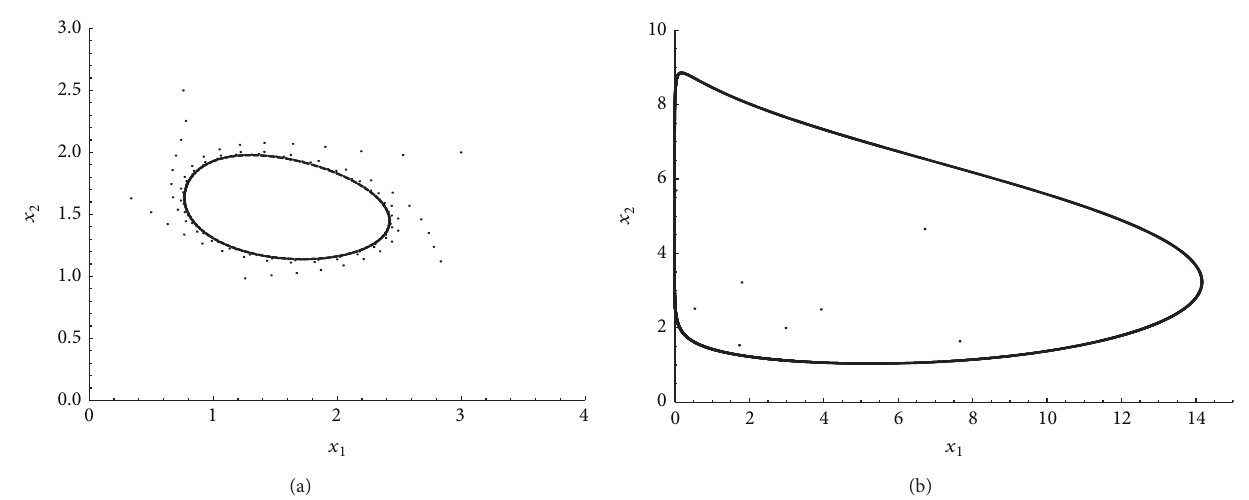
Figure 2: (a) An invariant curve just beyond instability threshold. Parameter values 𝛽 1 = 𝛽 2 = 2 , 𝜇 1 = 𝜇 2 = 0.5 , and 𝐹 = 20 . (b) The attractor when 𝐹 = 107 . Other parameter values as in